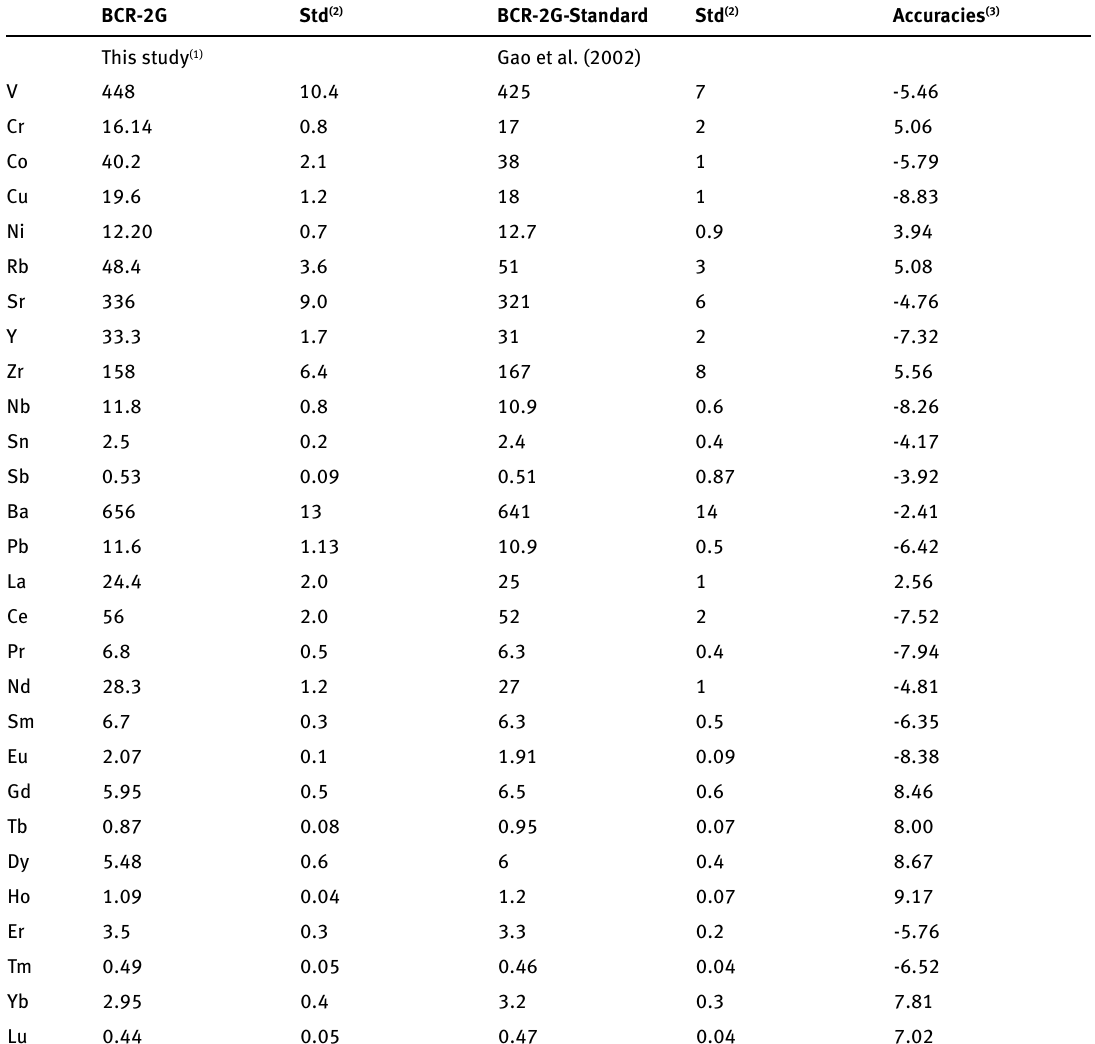
Table 2: Analyses by LA-ICP-MS of BCR-2G (United States Geological Survey) standard glass (in ppm). Comparison between literature data (Gao et al., 2002) and results from present